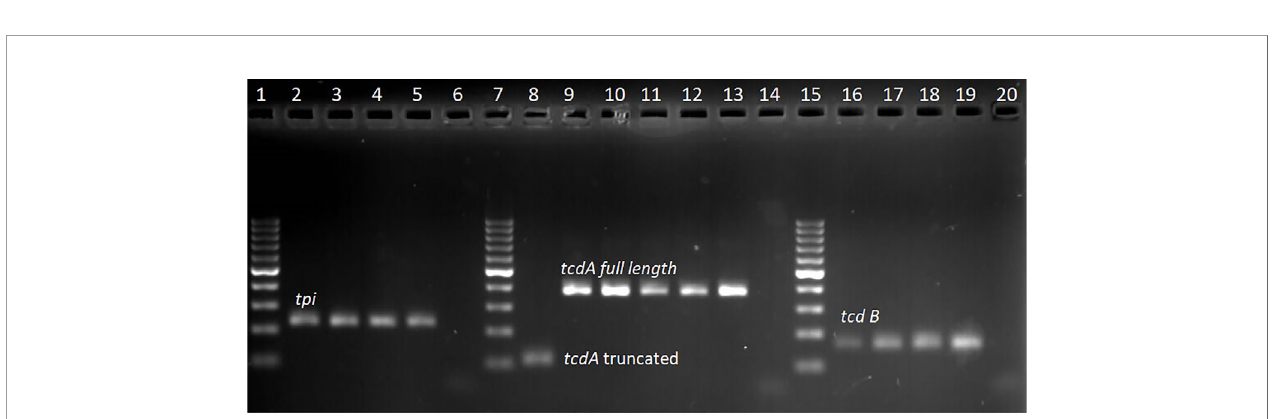
FIGURE 2 | Gel electrophoresis of qPCR amplicon products; lanes 1, 7, and 15 represent 100 bp molecular weight marker, lanes 2 – 4 tpi positive (230 bp) clinical isolates, lane 5 tpi positive control ( C. dif fi cile DSM 27147), lane 6 no template control. Lane 8 clinical isolate with truncated tcdA (110 bp) amplicon, lane 9 – 12 clinical isolates with full length tcdA gene (369 bp), lane 13 positive control ( C. dif fi cile DSM 27147), and lane 14 no template control. Lane 16 – 18 clinical samples with tcdB gene (160 bp), lane 19 positive control ( C. dif fi cile DSM 27147), and lane 20 no template